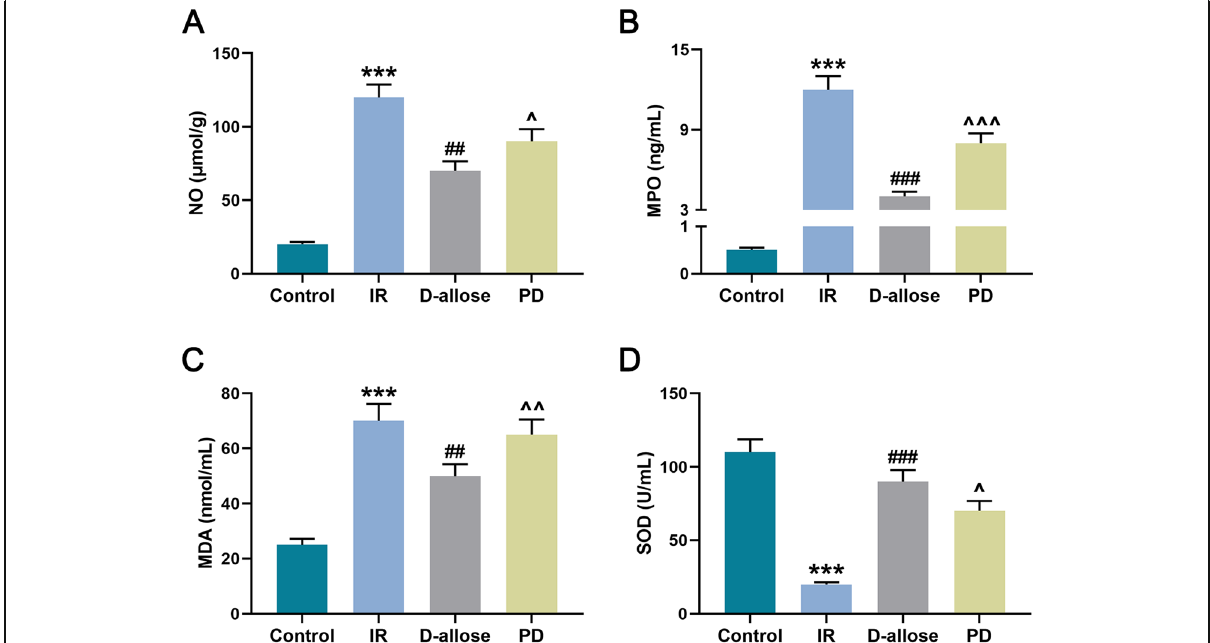
Fig. 3 D-allose suppressed oxidative stress in skin flap injured by I/R. a NO ( μ mol/g) level in skin flap was measured by ELISA in Control, IR, D- allose and PD groups; b MPO (ng/mL) level in skin flap was measured by ELISA in each group; c MDA (nmol/mL) level in skin flap was measured by ELISA in each group; d SOD (U/mL) level in skin flap was measured by ELISA in each group. Bars indicated means ±SD. *** P < 0.001 vs. Control; ### P < 0.001, ## P < 0.01 vs. IR; ^^^ P < 0.001, ^^ P < 0.01, ^ P < 0.05 vs.